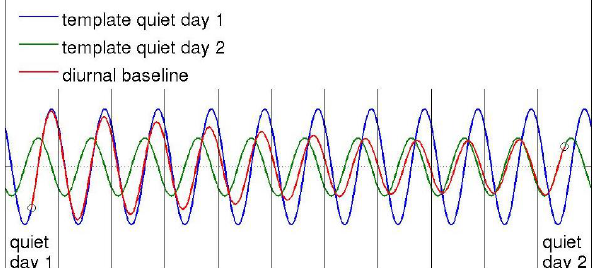
Fig. 8. The principle of interpolation between templates. Templates derived from two consecutive quiet days, and the diurnal baseline, linearly interpolated between them. The vertical lines mark mid- nights (separation between days).